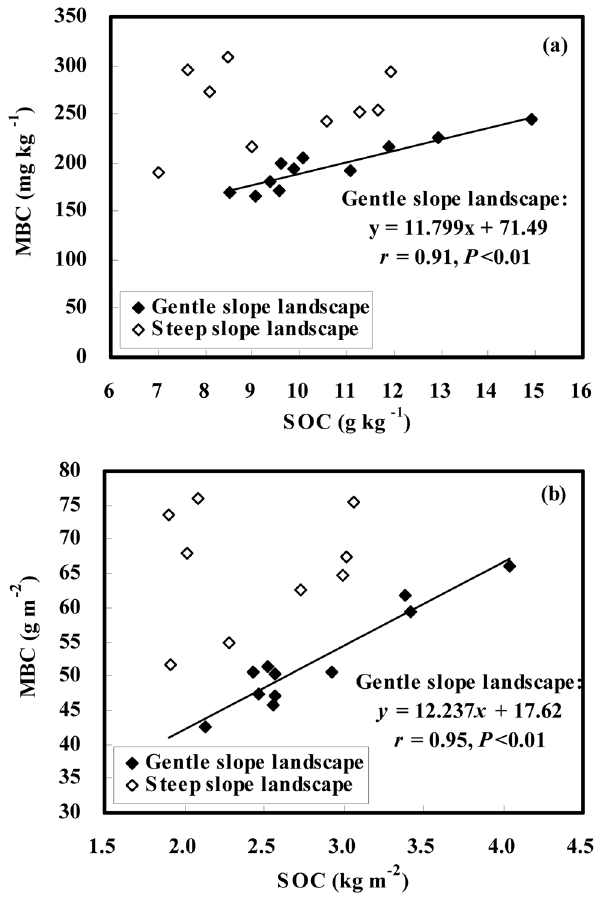
Figure 6. Relationship between MBC and SOC in gentle and steep slope landscapes. (a) mass basis; (b) area